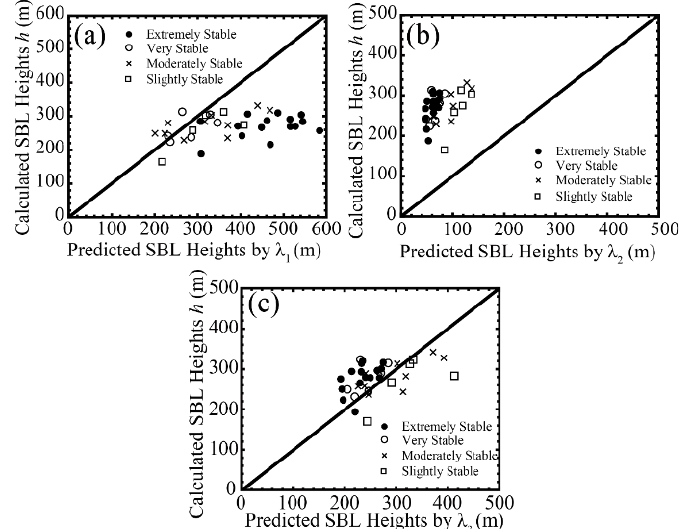
Figure 6. Scatter diagrams of the predicted versus the calculated heights of the stable boundary layer: ( a ) 𝜆 1 = 𝑘𝑢 ∗ /𝑓 vs ℎ , ( b ) 𝜆 2 = ( 1